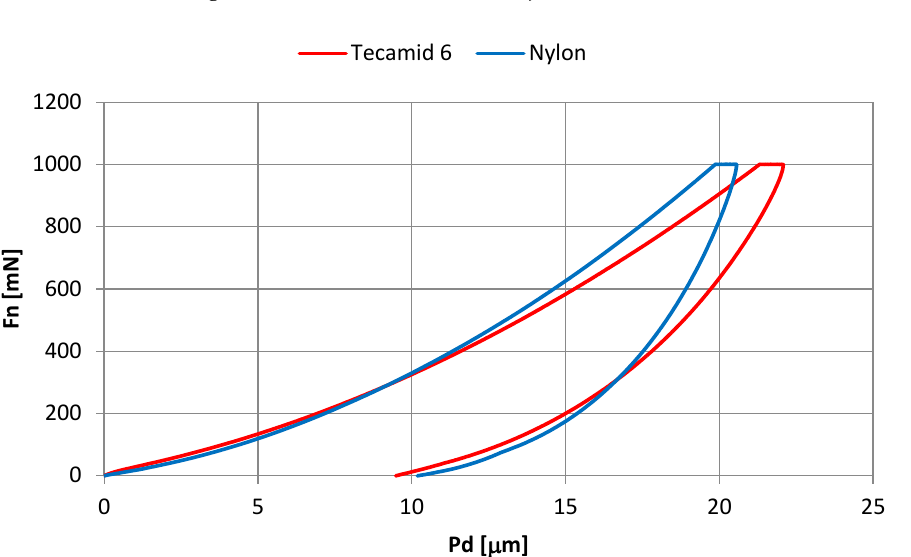
Figure 7. Mean normal curves (Fn)—penetration depth of the indenter (Pd).